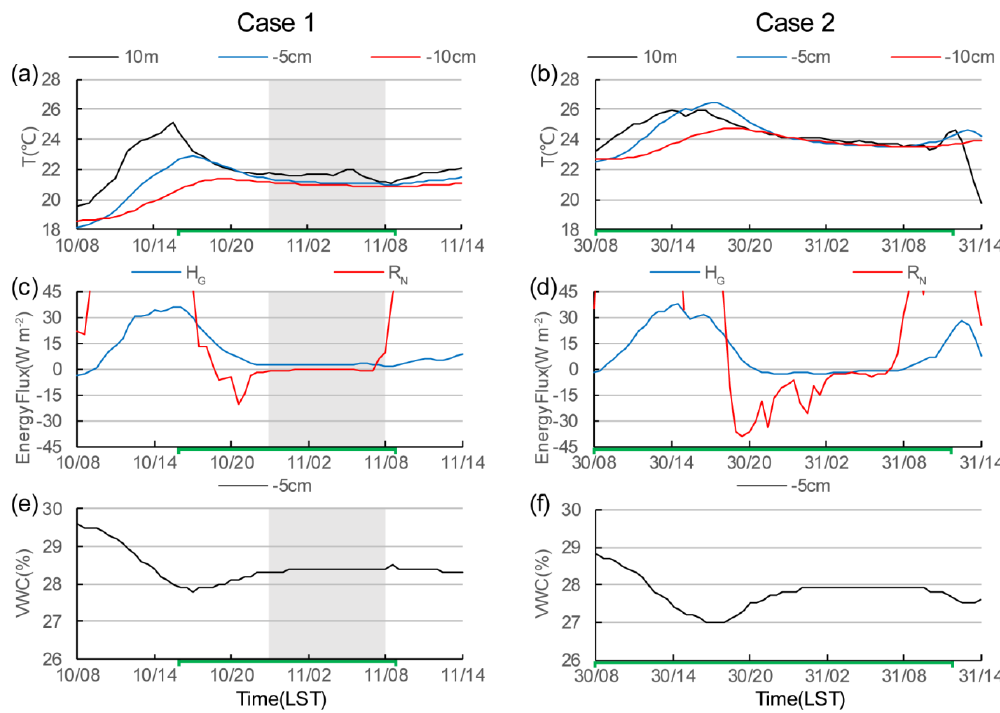
Figure 15. Land–atmosphere exchange characteristics at the inland site C. ( a , b ) Air (10 m AGL) and soil temperatures (5 and 10 cm depths) for cases 1 (left) and 2 (right). ( c , d ) Soil heat flux (H G , positive downward) and net radiation ( R N , positive downward) for both cases. ( e , f ) Soil volumetric water content (VWC) at 5 cm depth for both cases. The green line indicates the sea-fog period, the grey shading indicates the inland-fog period.